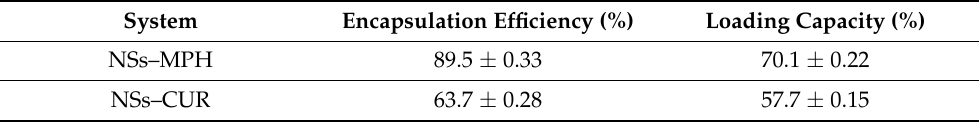
Table 5. EE% and LC% of the NSs–MPH and NSs–CUR systems.